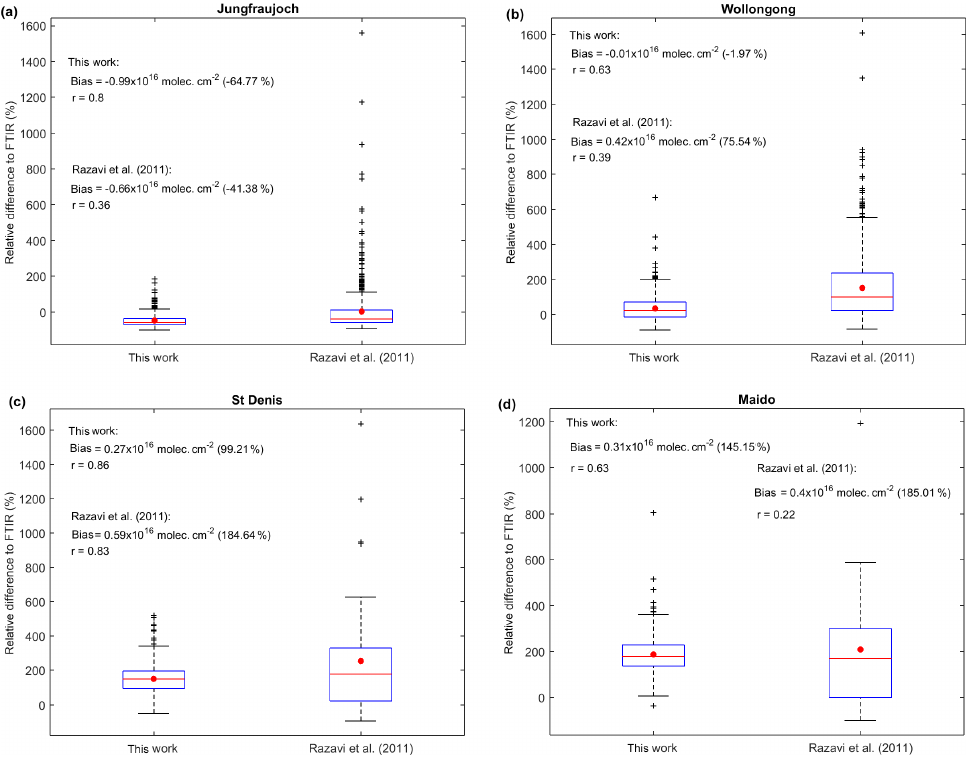
Figure 10. Box and whisker plots showing mean (red central circle), median (red central line), and 25th and 75th percentile (blue box edges) of the relative difference between the HCOOH derived using the IASI radiance observations from this work or using the conversion from Razavi et al. (2011) and the FTIR measurements for each station: Jungfraujoch, Wollongong, Saint-Denis, and Maido. The whiskers encompass values from 25th − 1 . 5 × ( 75th − 25th) to the 75th + 1 . 5 × ( 75th − 25th). This range covers more than 99% of a normally distributed data set. The outliers are represented individually by black crosses. For this comparison, the IASI data are collocated at ± 4 ◦ around the site location. The mean bias, the normalized mean bias (in parentheses), and the correlation coefficient are given for both methods.